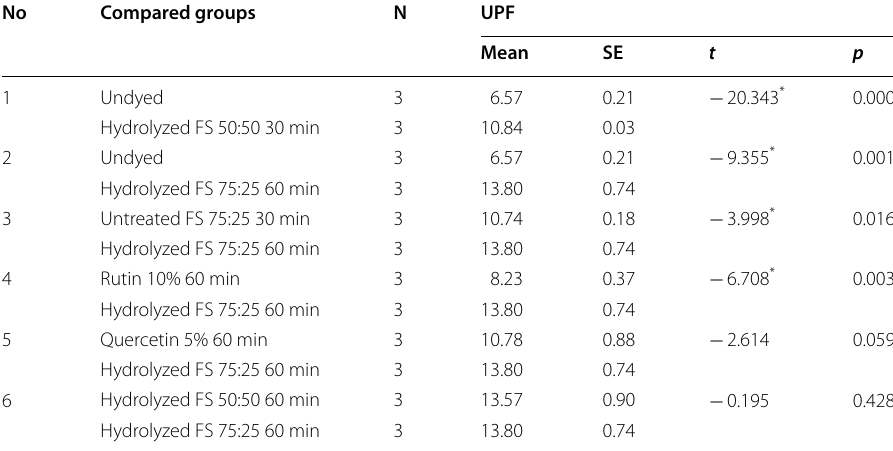
Table 12 Results of independent t-test on the UPF values No Compared